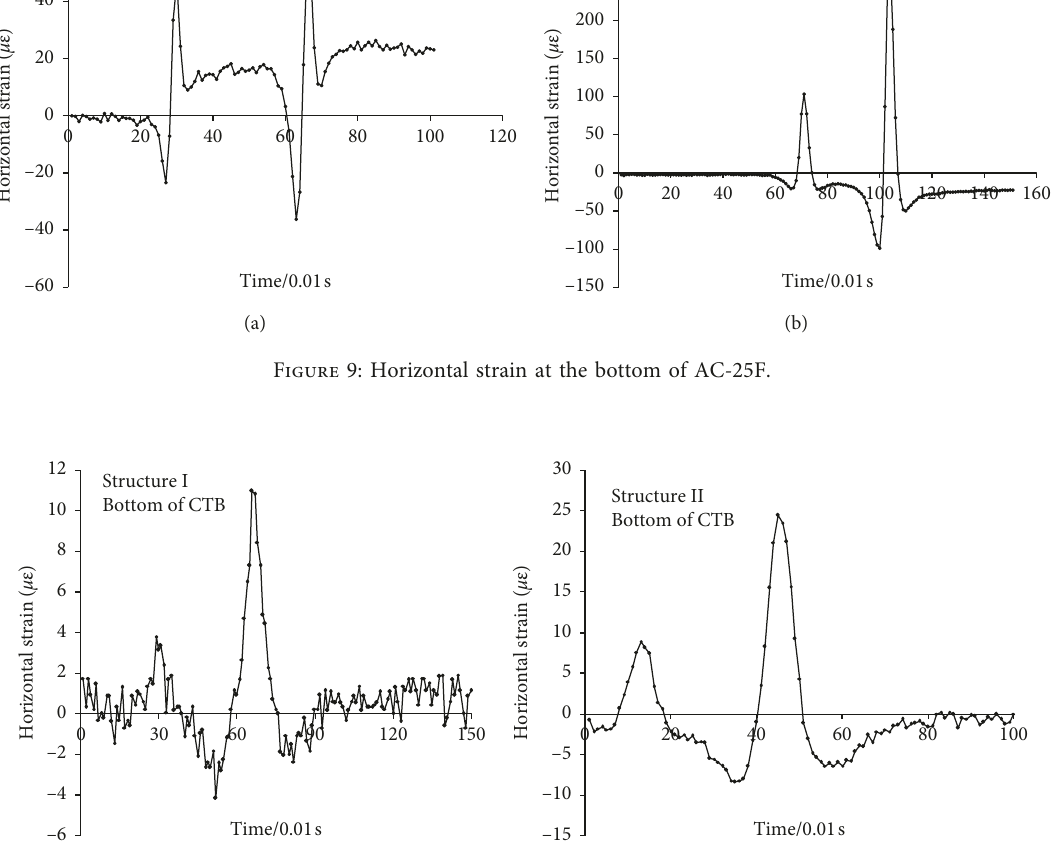
Figure 10: Horizontal strain at the bottom of the cement-stabilized